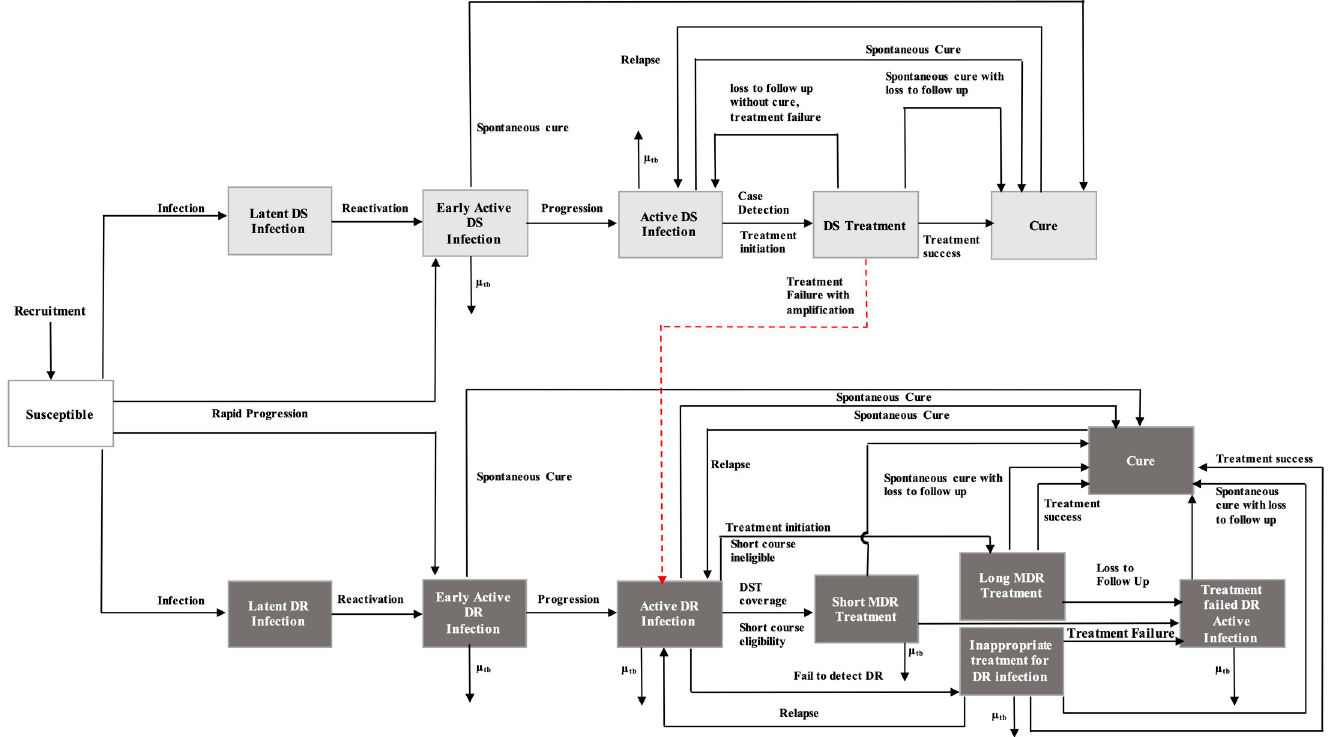
Fig 1. Model structure for drug-susceptible (DS)- and multidrug-resistant (MDR)-TB.